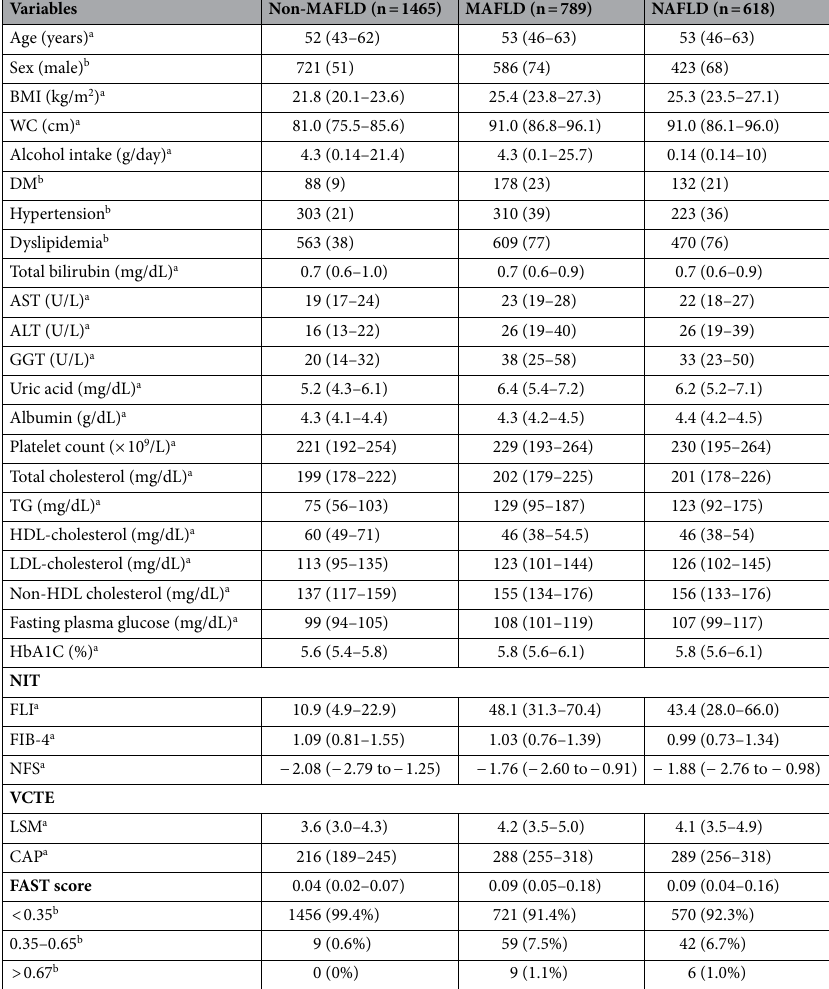
Table 1. Clinical characteristics of patients with MAFLD and NAFLD. ALT: alanine aminotransferase; AST: aspartate aminotransferase; BMI: body mass index; CAP, controlled attenuation parameter; DM: diabetes mellitus; FAST: FibroScan-aspartate aminotransferase; FIB-4: fibrosis-4; FLD: fatty liver disease; FLI: fatty liver index; GGT: gamma-glutamyltransferase; HDL: high-density lipoprotein; LDL: low-density lipoprotein; LSM, liver stiffness measurement; MAFLD: metabolic dysfunction-associated fatty liver disease ; NAFLD: nonalcoholic fatty liver disease; NFS: NAFLD fibrosis score; NIT: noninvasive test; TG: triglycerides; VCTE: vibration controlled transient elastography; WC: waist circumference. a Median (interquartile range), b number